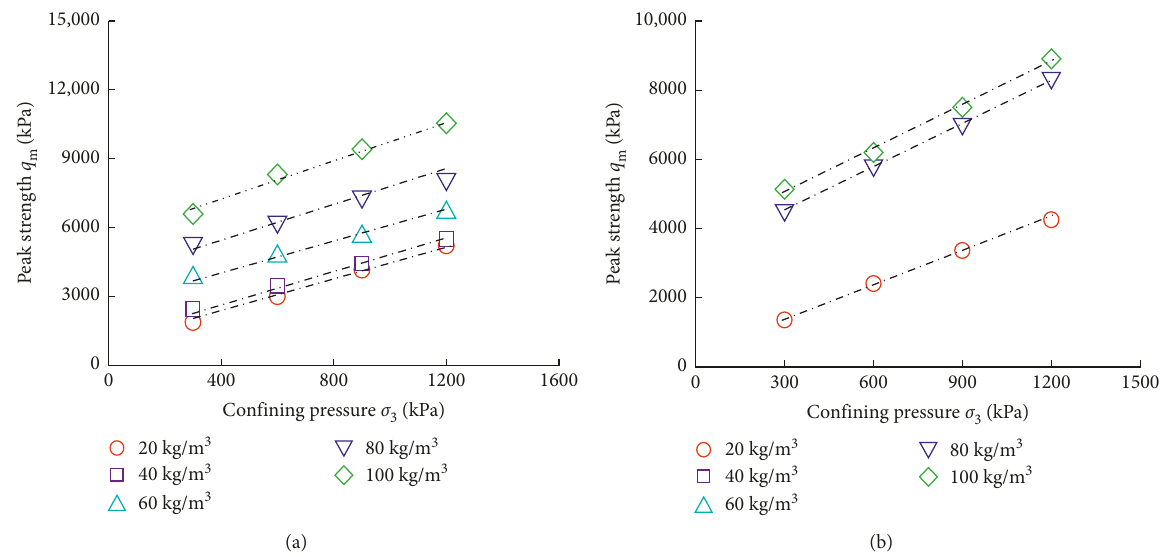
Figure 5: Relation curves of peak strength and confining pressure of CSG material with different cementing agent contents: (a) Material I and (b) Material